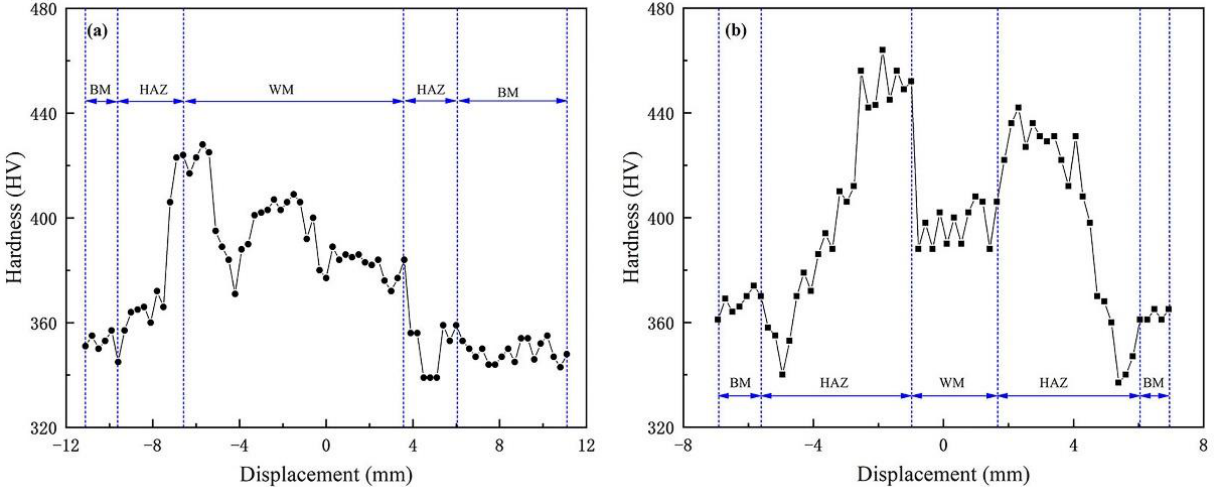
Figure 12. Vickers microhardness distributions ( a ) Hardness area of the SMAW joint ( b ) Hardness area of the LBW joint.